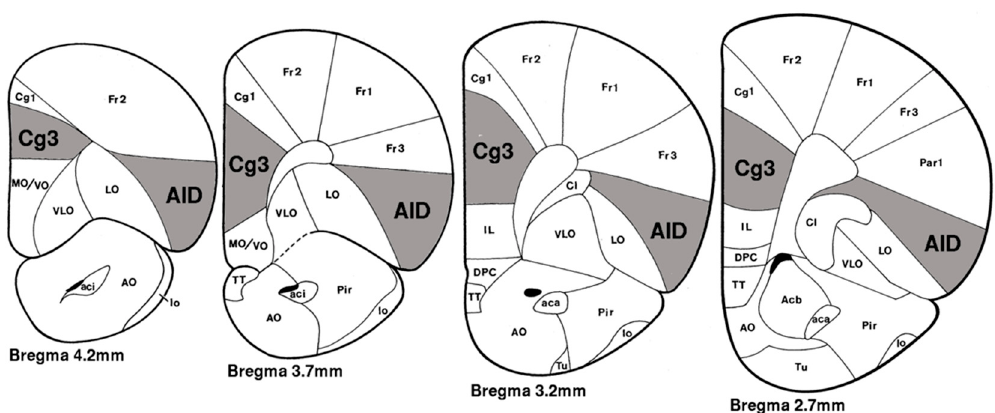
Figure 1. Agranular insular cortex (AID) and Prelimbic (Zilles’ area Cg3) regions extending from 2.7 to 4.2 mm anterior to Bregma from which neurons were sampled (Adapted from Zilles [15]). Abbreviations for other areas shown here, but not analyzed in the present study: Acb, nucleus accumbens; aci, anterior commisure (intrabulbar); AO, anterior olfactory nucleus; Cg1, anterior cingulate, Cl, claustrum; DPC, dorsal peduncular cortex; Fr1–3, frontal cortex; IL, infralimbic cortex; lo, lateral olfactory tract; LO, lateral orbital area; MO, medial orbital area; Par1, parietal cortex; Pir, piriform cortex; TT, taenia tecta; Tu, olfactory tubercle; VLO, ventrolateral orbital area; VO, ventral orbital area. Reprinted from [43] .